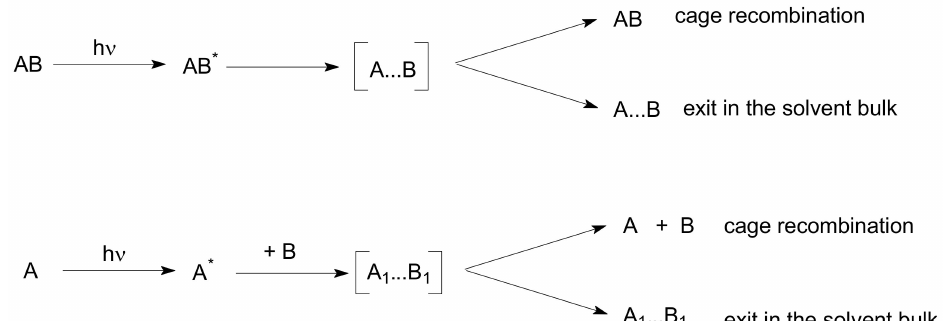
Scheme 1. Square brackets denote products of photoreactions are inside a solvent cage. Photoreactive molecules AB (top part) or A (bottom part) can be in a singlet or in a triplet state. The triplet state is formed after intersystem crossing in the excited singlet